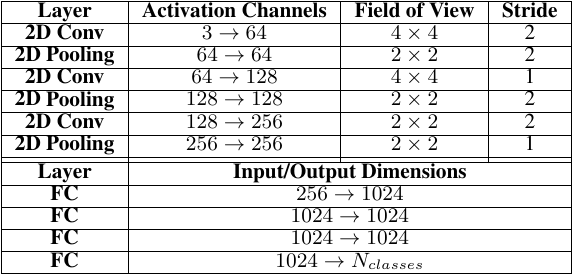
Figure 1. Context window used to evaluate each pixel in the Pixelwise network. All the pixels marked in green are used as the context of the pixel marked as red. Table 1. OpenPixel architecture layers and parameters. Layer Activation Channels Field of